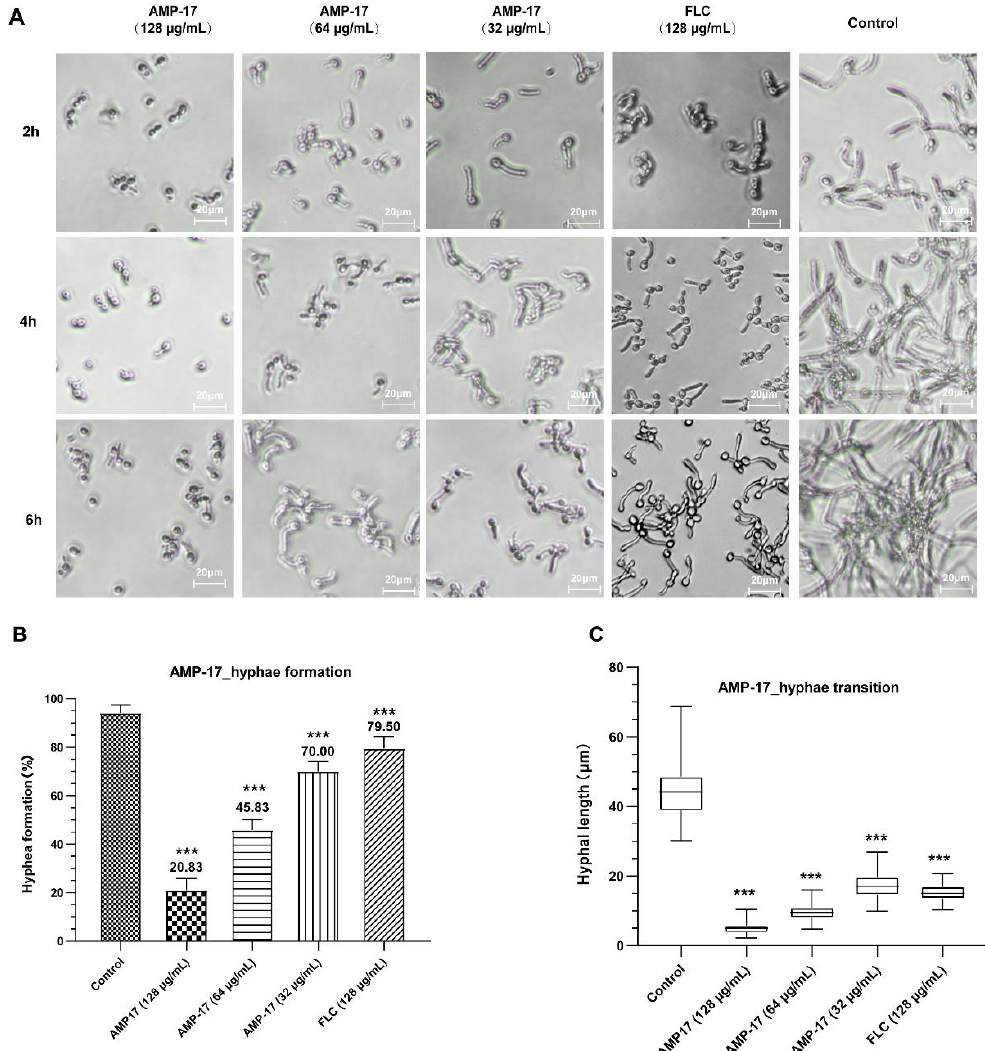
Figure 5. The effect of AMP-17 on the yeast-to-hypha transition and filamentous growth in C. albicans . ( A ) The effects of AMP-17 on yeast-to-hypha transition in RPMI 1640 medium. AMP-17 was diluted in RPMI 1640- FBS medium to final concentrations of 32 μg/mL, 64 μg/mL, and 128μg/mL , and FLC to the concentration of 128 μg/mL as a positive control. Bar, 20 μm. ( B ) The hyphae formation rate of C. albicans cells exposed to different concentrations of AMP-17 in RPMI medium for 2 h. ( C ) The hyphal length of C. albicans after treatment with different concentrations of AMP-17 in RPMI medium for 2 h, measured using Image J. Error bars represent the standard deviation of three independent experiments. *** p < 0.001 compared to the control group.